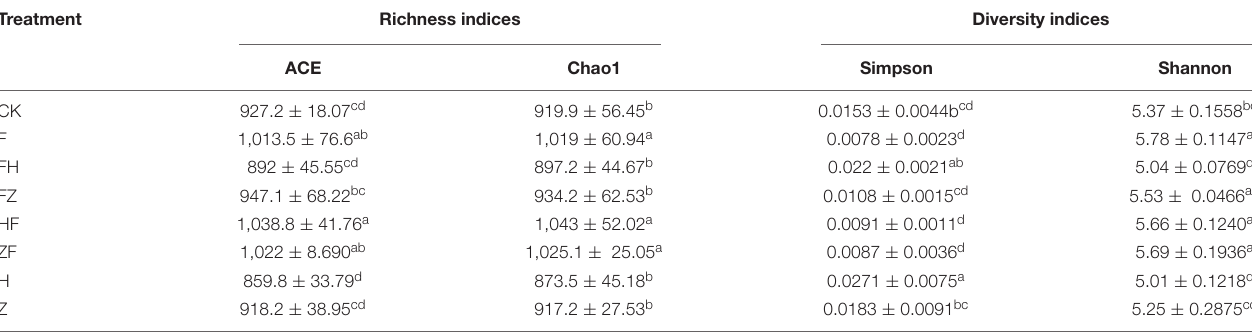
FIGURE 6 | Rarefaction curves (A) showing the relationship between sequence number per sample and observed OTUs for different treatment replicates. The length of the curve reflects sequencing depth (i.e., a longer curve indicates a greater depth), while the smoothness reflects the effect of sequencing depth on sample diversity. Principal component analysis (B) based on the distance matrix calculated using the Bray-Curtis algorithm for soil samples collected from different treatments: CK, control; F, F. oxysporum alone; FH, F. oxysporum + HSB1; FZ, F. oxysporum + FZB42; H, HSB1 alone; HF, HSB1 + F. oxysporum ; Z, FZB42 alone; ZF, FZB42 + F. oxysporum . TABLE 3 | The mean of the ACE, Chao1, and Simpson and Shannon indices of rhizosphere soil treatments with BCA and F. oxysporum at 97% similarity. Treatment Richness